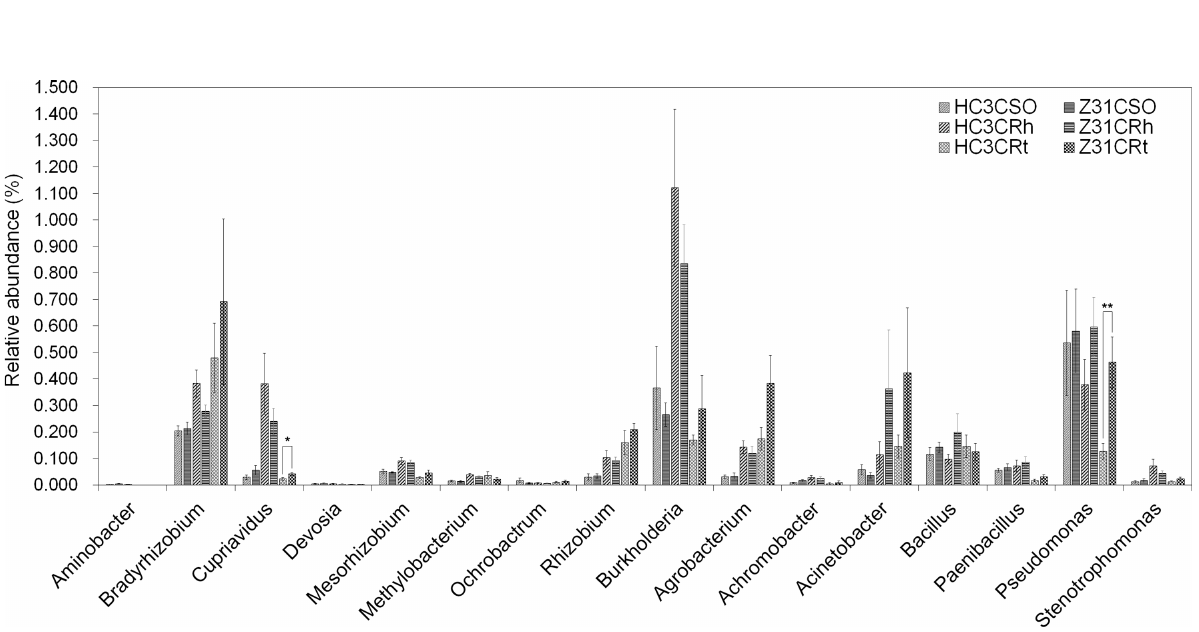
Fig 5. Relative abundances of main nitrogen-fixing bacterial genera at the flowering stage. HC3CRt and Z31CRt represent the roots of the recipient cultivar HC3 and the transgenic line Z31 at the flowering stage, respectively. HC3CRh and Z31CRh represent the rhizospheric soils of the recipient cultivar HC3 and the transgenic line Z31 at the flowering stage, respectively. HC3CSO and Z31CSO represent the surrounding soils of the recipient cultivar HC3 and the transgenic line Z31 at the flowering stage, respectively. Error bars indicate SE calculated by Metastats. Values are mean ± SE (n = 4 or 6); (cid:3) , P < 0.05; (cid:3)(cid:3) , P < 0.01.